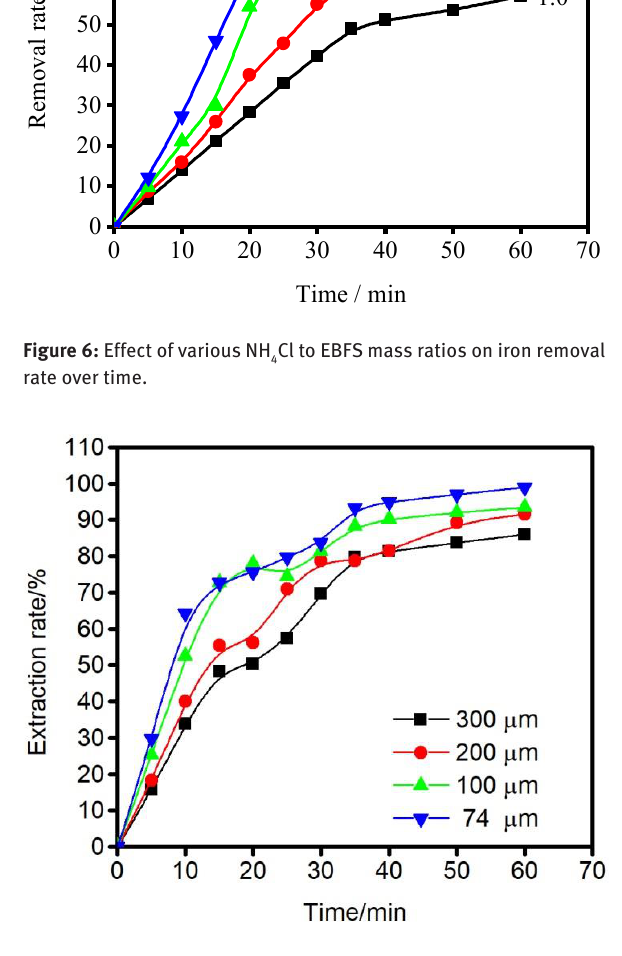
Figure 4. Effect of temperature on iron removal rates with time Figure 6. Effect of various NH 4 Cl to EBFS mass ratios on iron removal rate over time